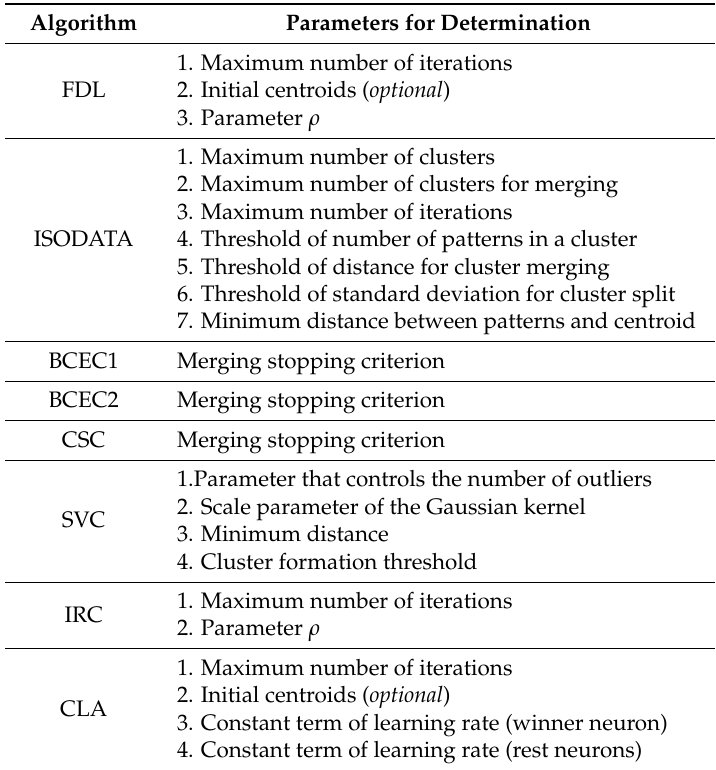
Table 6. Parameters of the rest algorithms.